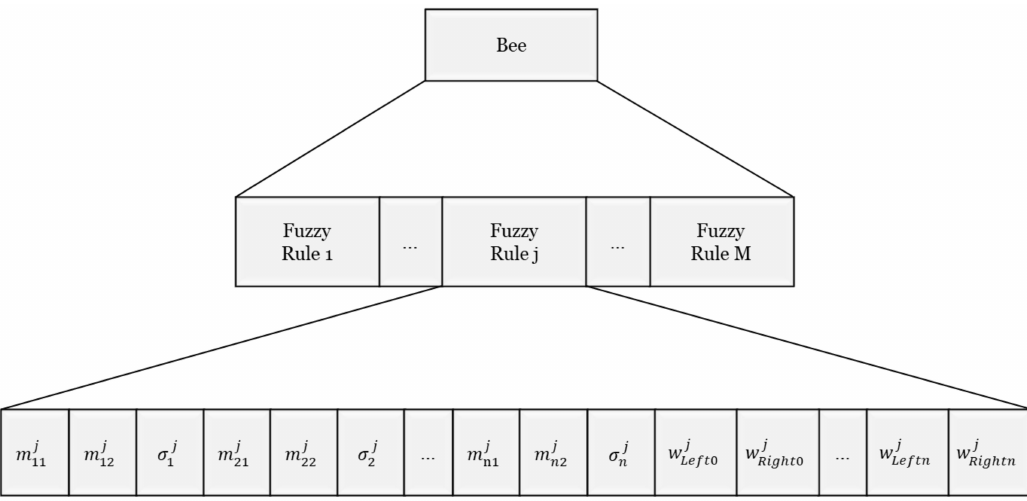
Figure 4. Coding of a